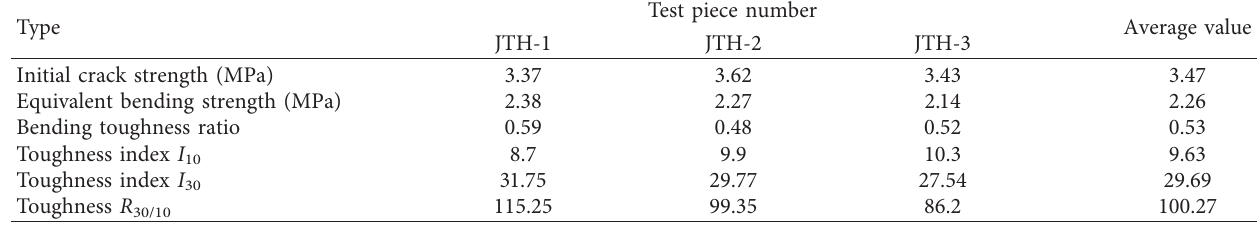
Table 4: Test results of flexural toughness.